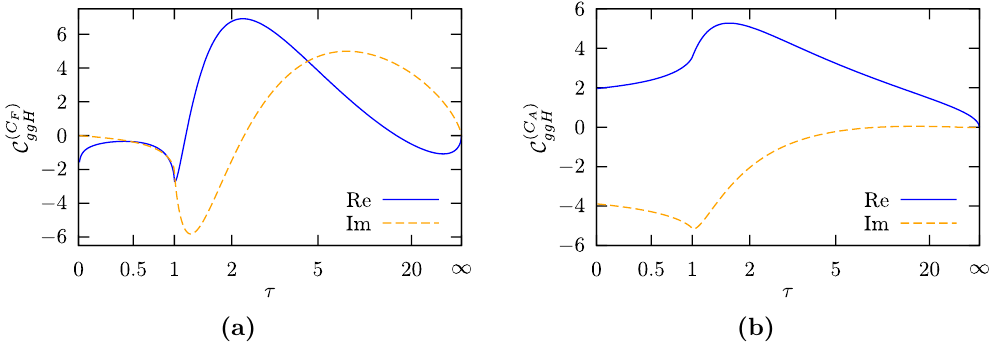
Figure 3 . Contributions to ~ C (2) separated by their color factors. The quark mass is renormalized ggH in the on-shell scheme and the renormalization scale is set to (cid:22) 2 = M 2